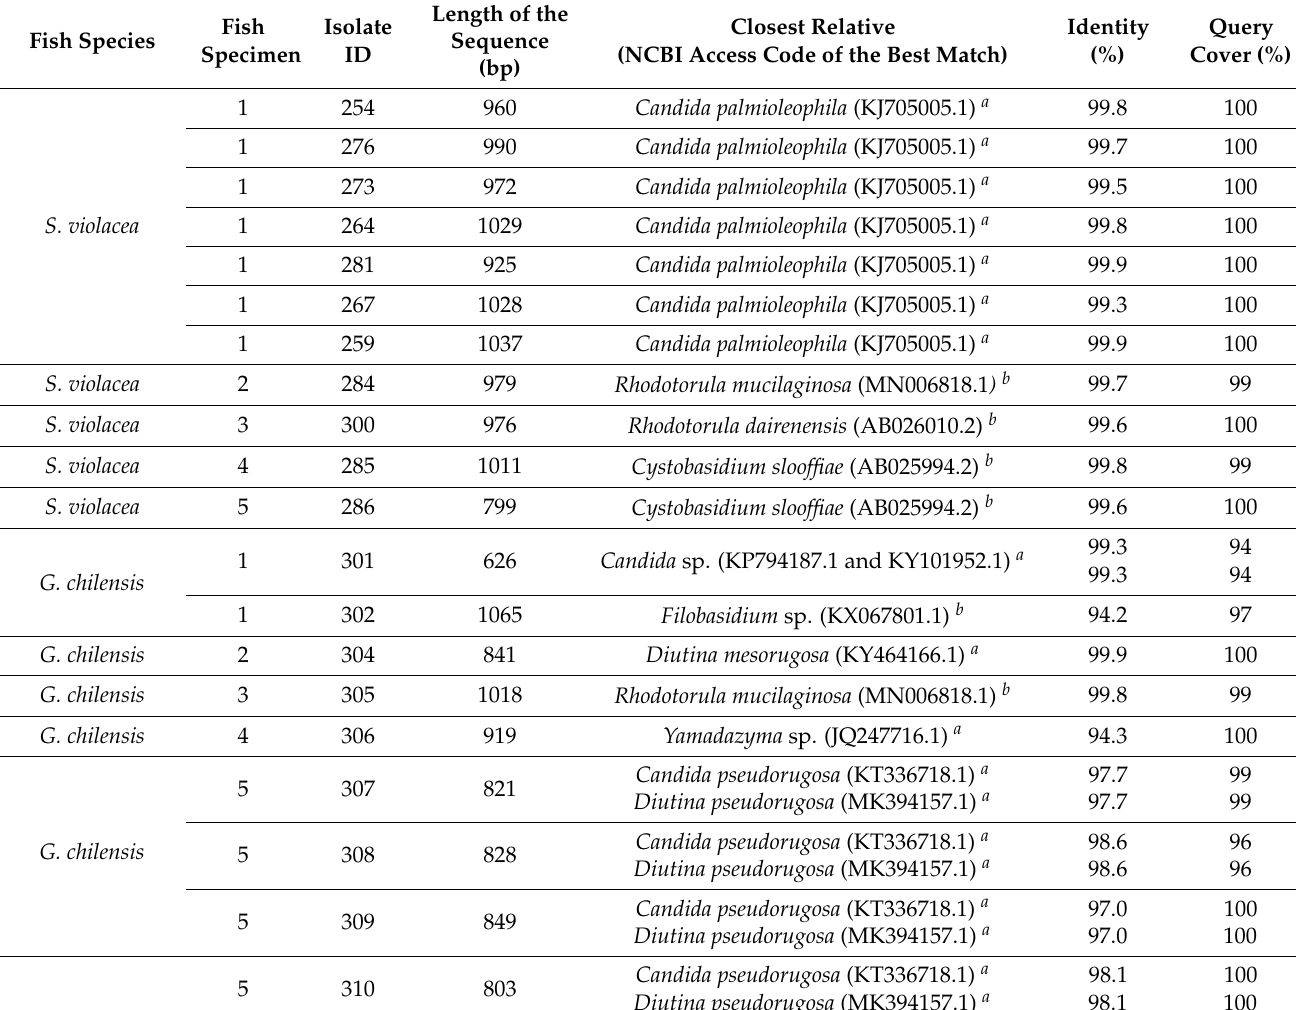
Table 1. Identification of the yeast isolated from Seriolella violacea and Genypterus